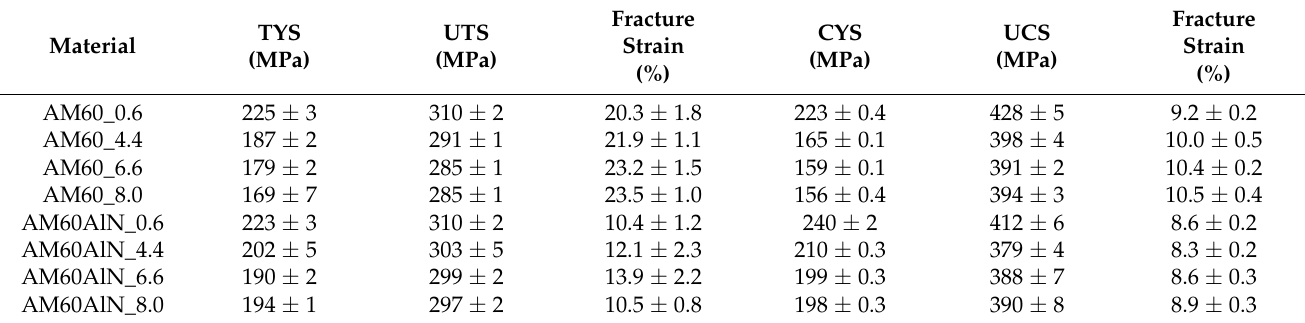
Table 1. Results of tensile and compression tests at room temperature. UTS: ultimate tensile strength; TYS: tensile yield strength; UCS: ultimate compressive strength; CYS: compressive yield strength.